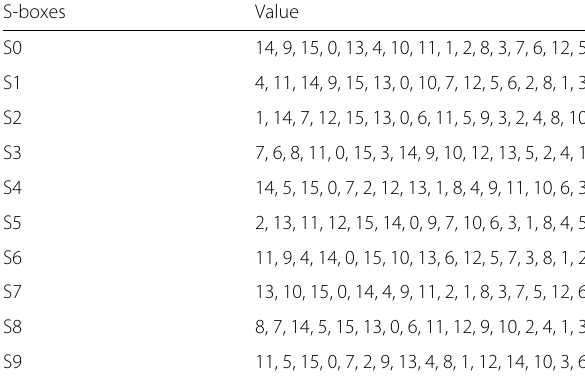
Table 3 The S-boxes used in LBlock